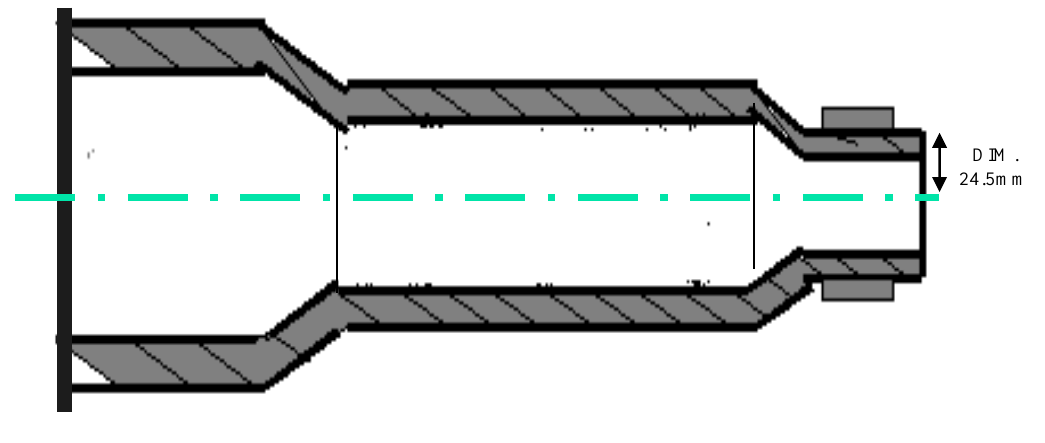
Figure 10. Dimension bottom case centre to axle- hole face